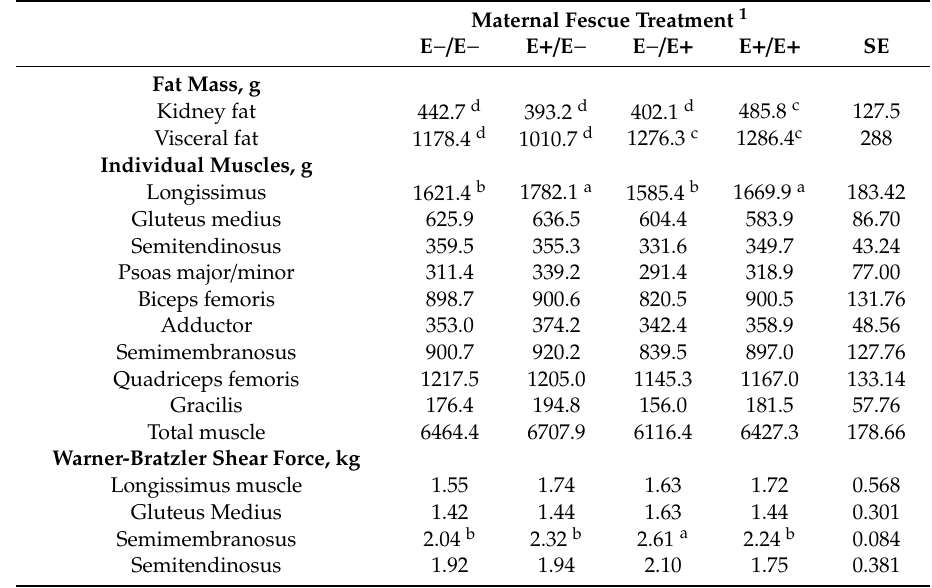
Table 4. Post weaning adipose and muscle weights, and Warner–Bratzler shear force values in carcasses from wethers born to ewes consuming endophyte-infected (E + ) or endophyte-free (E − ) fescue during MID (d 35-85) and LATE (d 86- parturition)